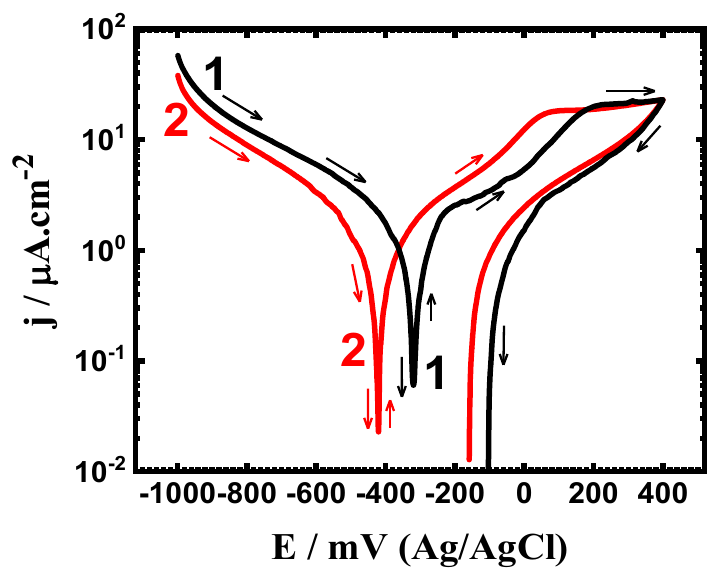
Figure 2. Cyclic polarization (PCP) curves obtained for (1) Ti and (2) Ti85-Zr15 after 1.0 h exposure to simulated body fluid (SBF).